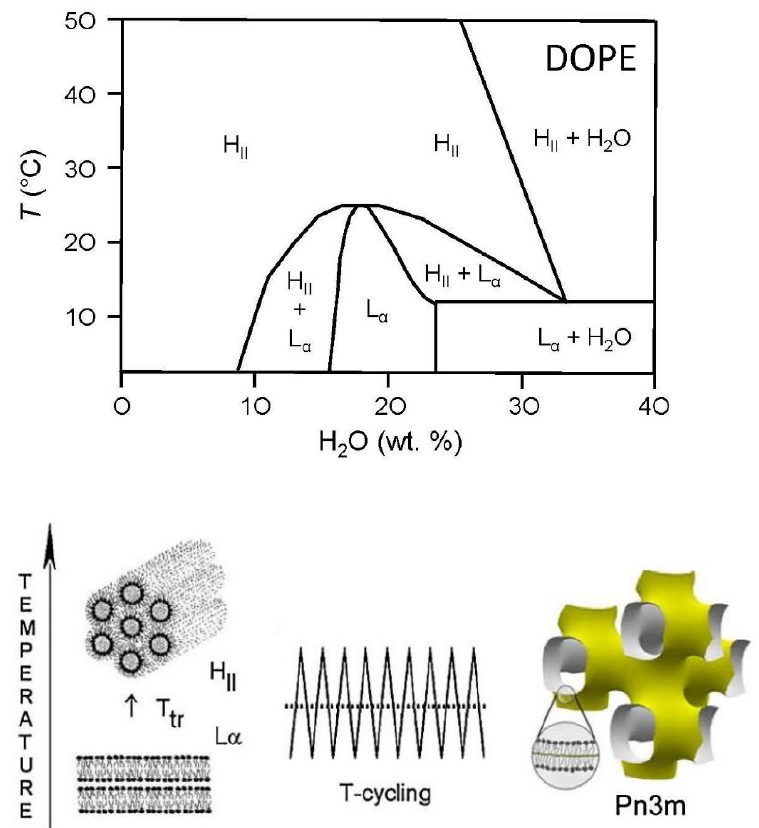
Figure 14. Aqueous dispersions of DOPE. Top : Calculated binary DOPE/water phase diagram, represented as mirror image of the diagram published by Kozlov et al. (1994) [119]. Bottom : Schematic representation of the (metastable) dispersed cubic phase formation upon temperature-cycling through a L α + H 2 O → H II + H 2 O transition, as published by Tenchov and Koynova (2017) [78]. Among the phosphatidylethanolamines investigated, the dispersed inverted cubic phase that formed from DOPE was Pn3m; in other cases, Im3m was obtained [78,120,121]. The experimental conditions in the case of DOPE were the following: 20 wt% DOPE in water, 1 M NaSCN, after 50 temperature-cycles (35–65 °C) and 7 days storage at T = 20 °C; the sealed sample was analyzed by X-ray diffraction measurements at T = 20 °C [78]. Reproduced with permission from [119], Elsevier, 1994; and from [78], Elsevier, 2017.